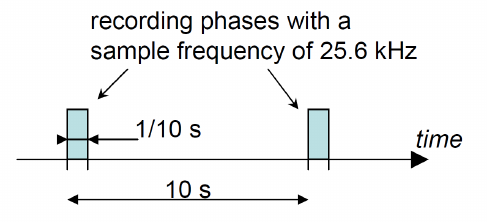
Figure 6. Sampling interval description of vibration